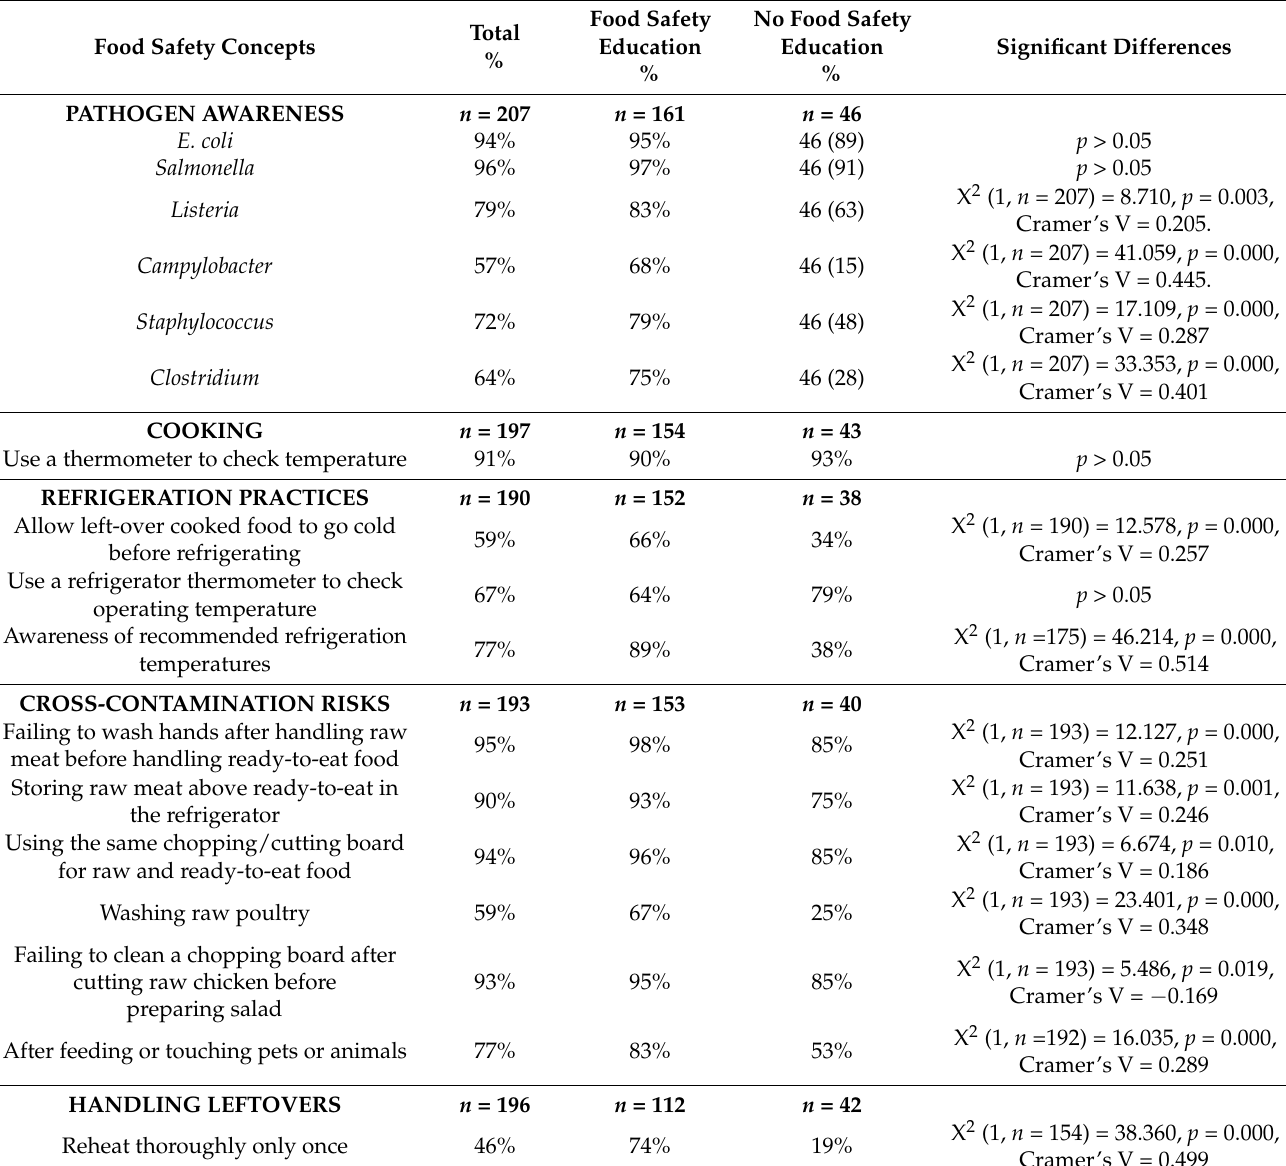
Table 2. Food safety awareness according to dietetic students that received food safety education and that did not receive food safety